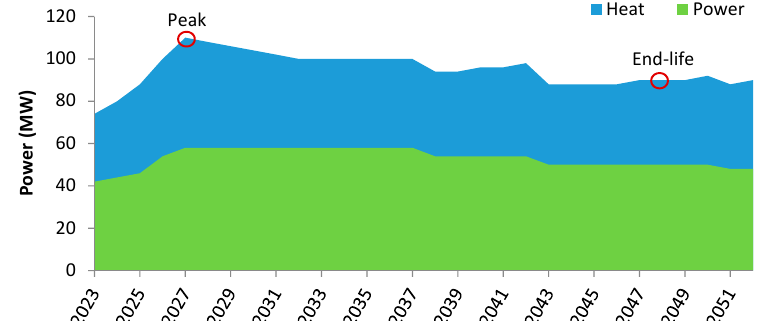
Figure 1. Power and heat demand profile for Johan Castberg [28].